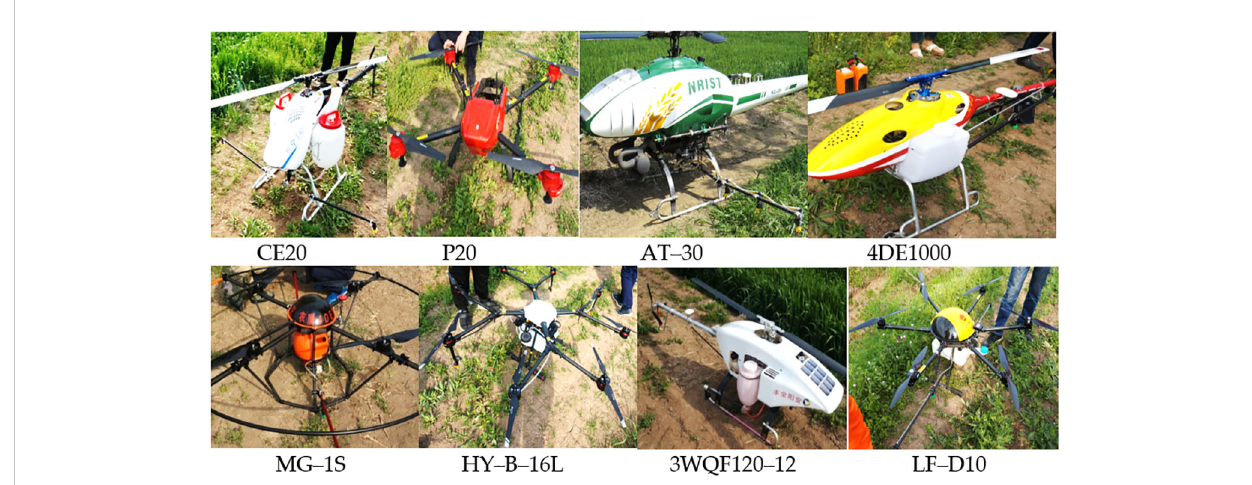
FIGURE 1 The UAVs used in testing. Note: the P20 is installed with four nozzles, but only two nozzles spray at a time. UAVs, unmanned aerial